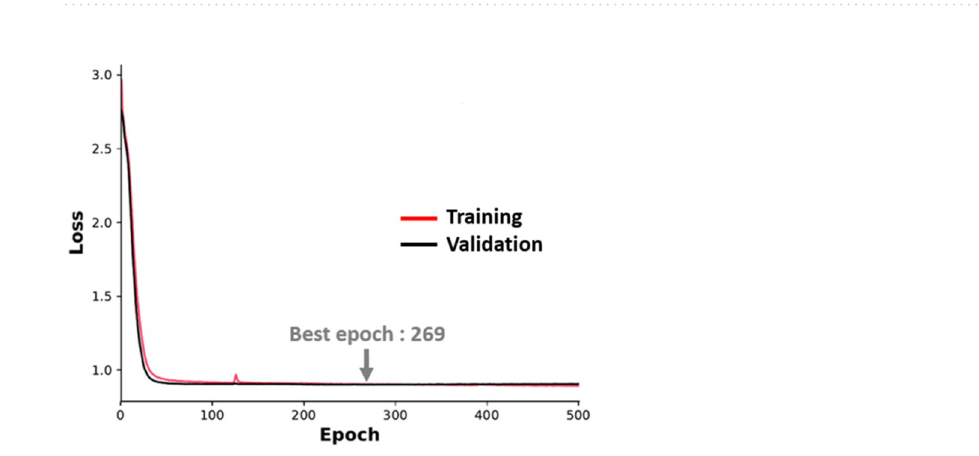
Figure 7. Loss evaluation of training and validation dataset. The best epoch is 269. Loss value is 0.9001. Training; red, Validation;